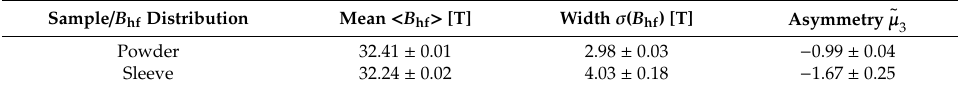
Figure 16. Distributions of hyperfine magnetic field corresponding to the martensite phase in the respective samples: ( a ) initial powder; ( b ) SLM fabricated sleeve. Table 5. Comparison of magnetic hyperfine field distribution P ( B hf ) parameters corresponding to martensite component (mean value, width—as square root of variance and Pearson–Fisher asymmetry coe ffi